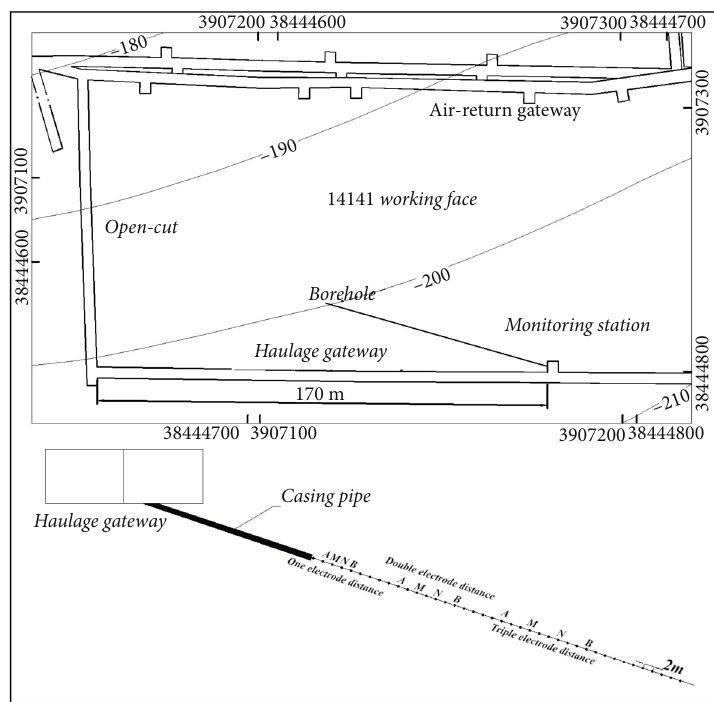
Figure 15: Monitoring station for the characteristics of fl oor mining failure.